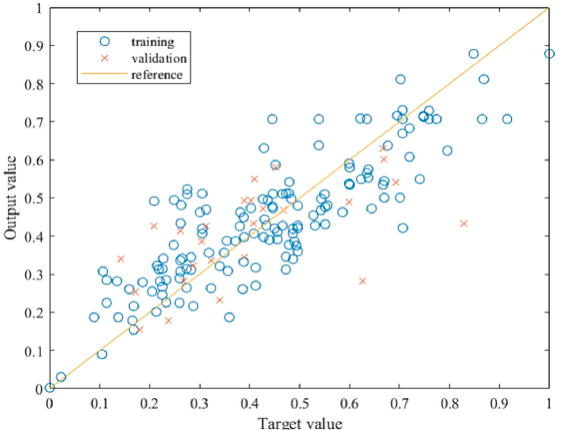
Figure 2. Relationship between the target and output values of the initial model. Optimization of the initial model has been performed by simply iterating the number of neurons in the hidden layer and observing the MSE for training and validation. To es- tablish the optimal number of neurons in the hidden layer, fifty iterations were carried out. The results of the optimization process are presented in Figure 3. It shows that over- fitting occurs with 49 neurons in the hidden layer. Vis-à-vis, underfitting may have oc- curred with 5, 8, 9, 12, and 13 neurons in the hidden layer. The literature recommends the highest number to be equal to 2 Ni + 1, where Ni is the number of input neurons. Thus, the preferred number of hidden neurons should be between fifteen and thirty, which is sup- ported by the results of the optimization of the network. A sudden drop or increase in the error for consecutive iterations may imply instability; hence, the error should show a rel- atively minimal change for several consecutive iterations. The behavior is somewhat steady within the range of 18 to 23 neurons, especially when the training MSE values are observed. Furthermore, within this range, the closest result between the training and the validation MSE occurs when the number of hidden neurons is 21, and thus it is considered to be an optimal value. Figure 3. MSE values after optimization of the initial model. 4.2. Training the Optimized ANN Model